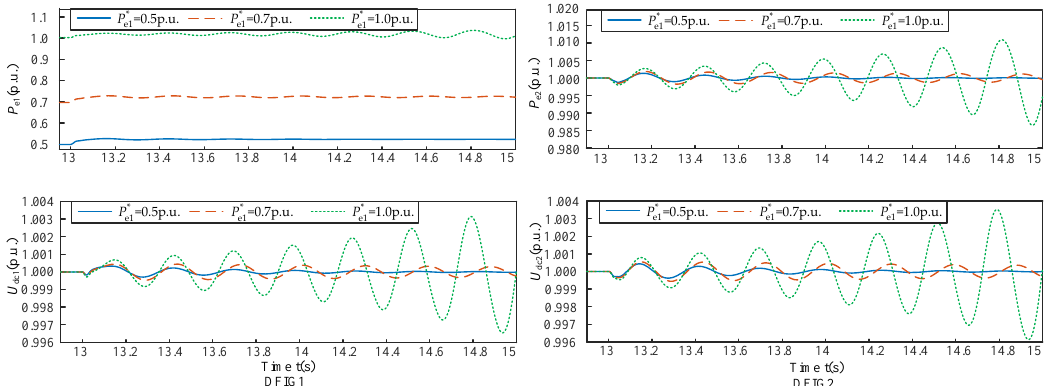
Figure 8. Active power outputs and DC-link voltages of the two-DFIG system with varied grid strengths.